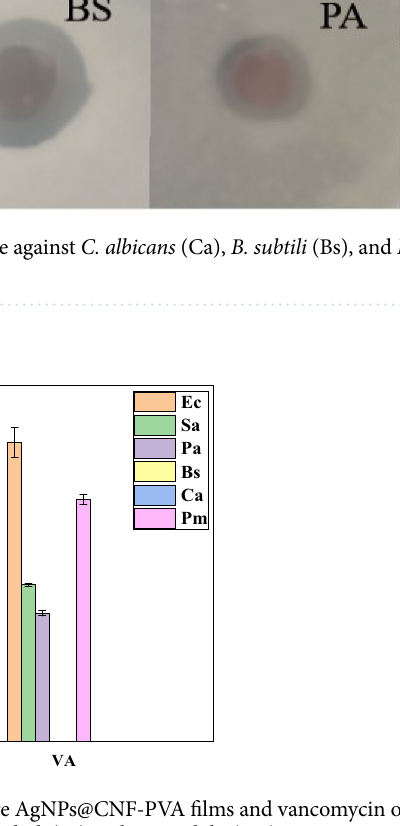
Figure 14. Inhibition zone assay of pure AgNPs@CNF-PVA films and vancomycin on the growth of C. albicans (Ca), E. coli (Ec) , P. aeruginosa (Pa) , B. subtili (Bs) and P. mirabilis